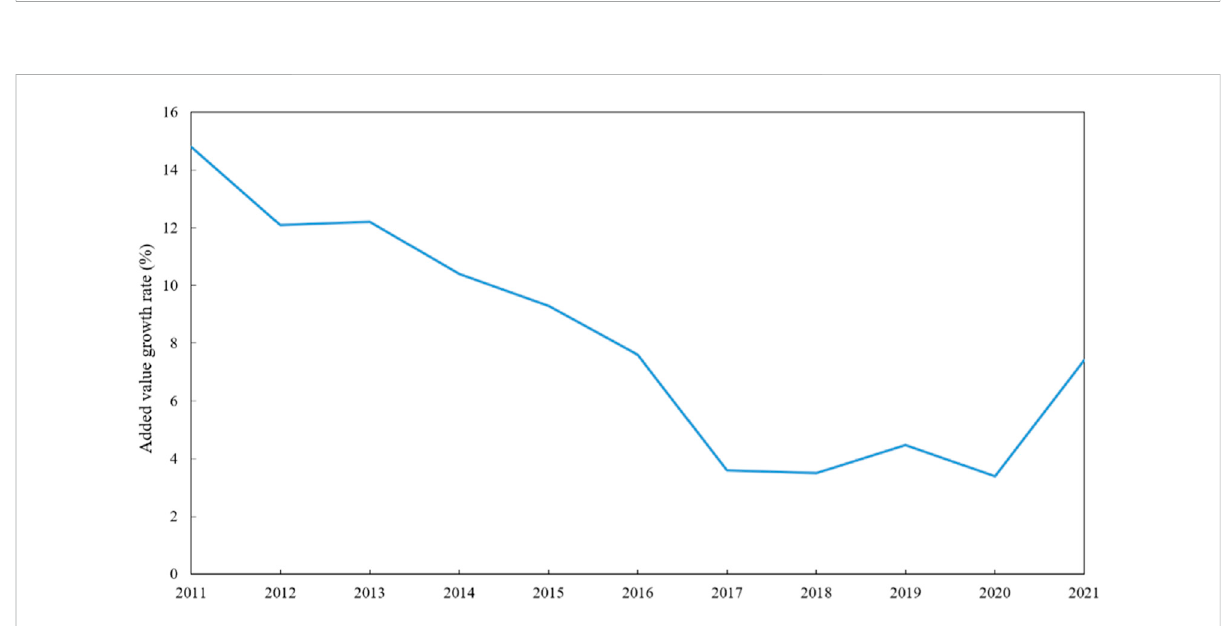
FIGURE 2 Growth rate of added value of chemical industry (Data source: